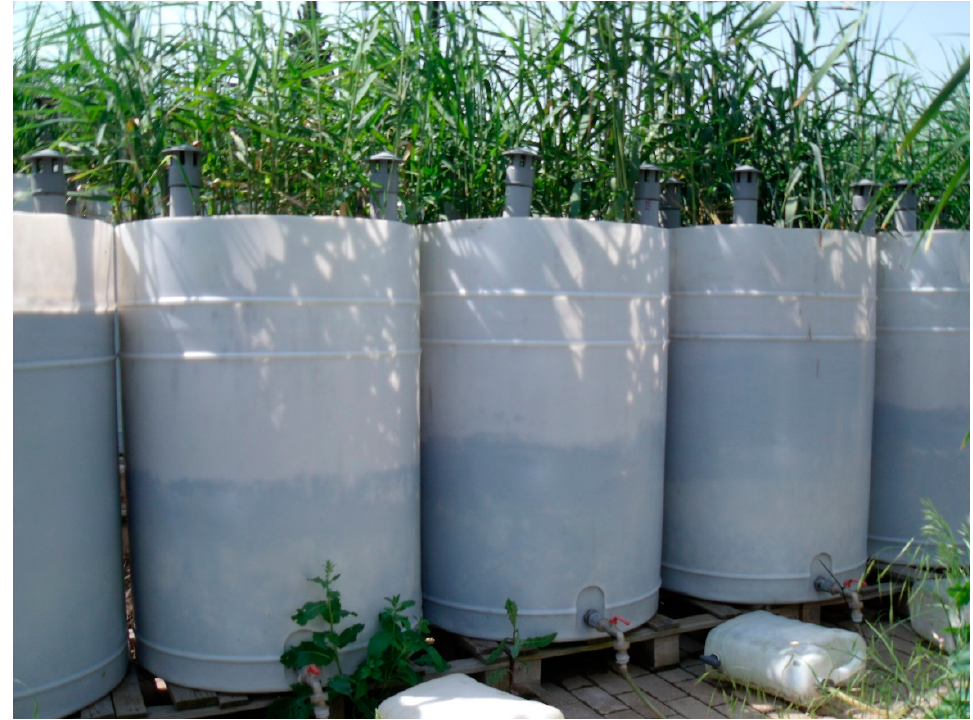
Figure 7. Picture of the pilot STRB in Xanthi (northern Greece) treating activated sludge with a high Cr content.